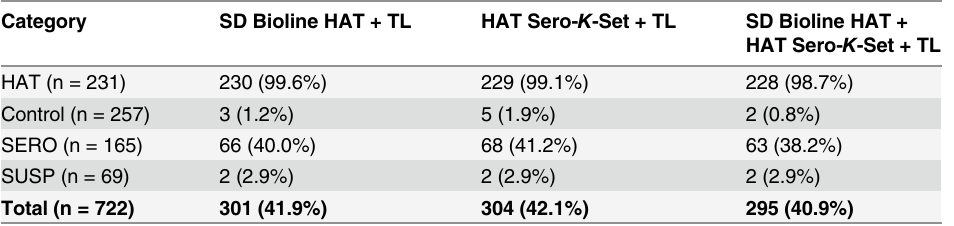
Table 4. Number of positive test results combining RDTs with trypanolysis, by type of study participant.